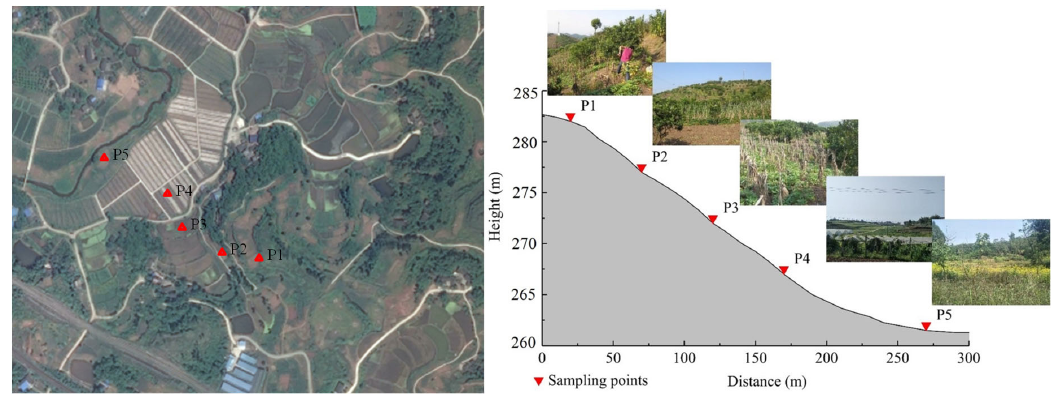
Figure 3. The distribution of sample points (P1 ‐ Vegetable field, P2 ‐ Gentle slope dryland, P3 ‐ Corn field, P4 ‐ Grapery, and P5 ‐ Abandoned dryland).